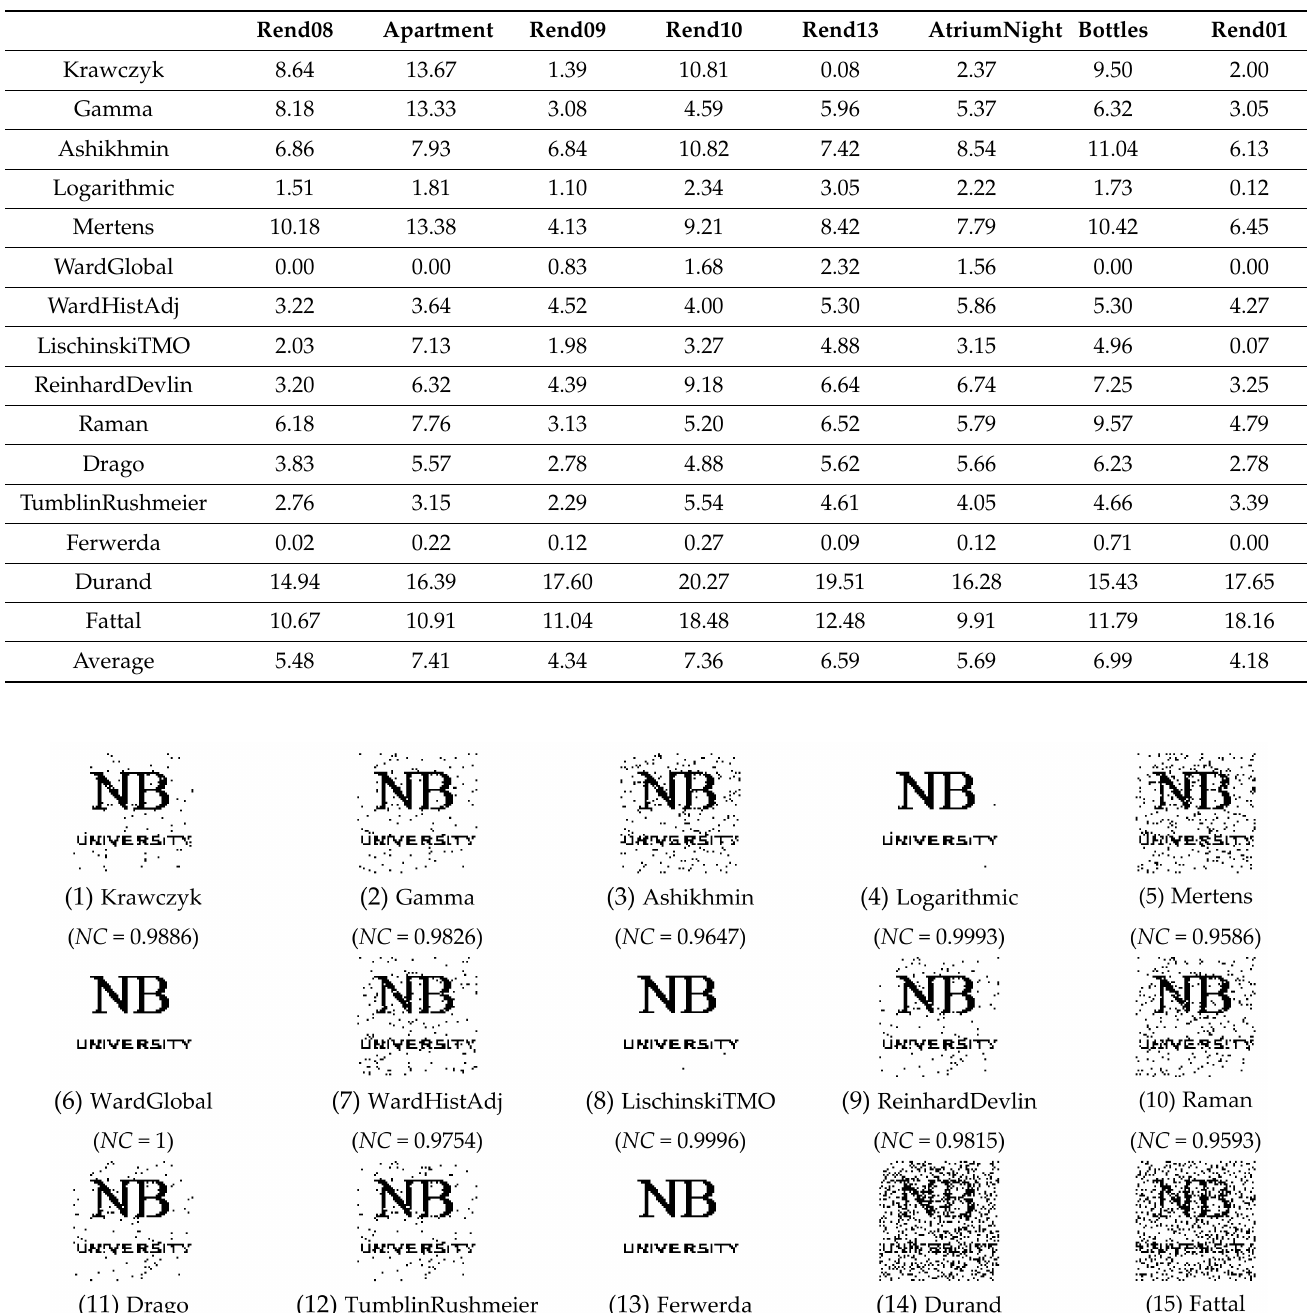
Table 2. BER s of HDR images while under TM attacks [%].